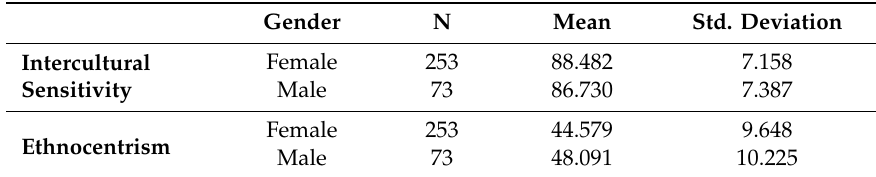
Table 2. Mean and standard deviation of students’ scores by gender in the Intercultural Sensitivity Scale and the Ethnocentrism Scale.